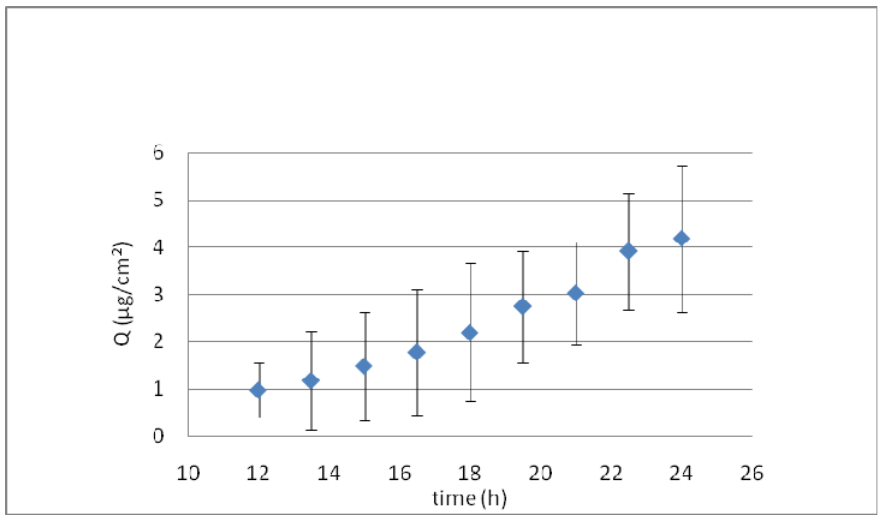
Figure 6. Cumulative amount of KT (Q) permeated through the skin ex vivo from elastic liposomes (means ± SD, n =